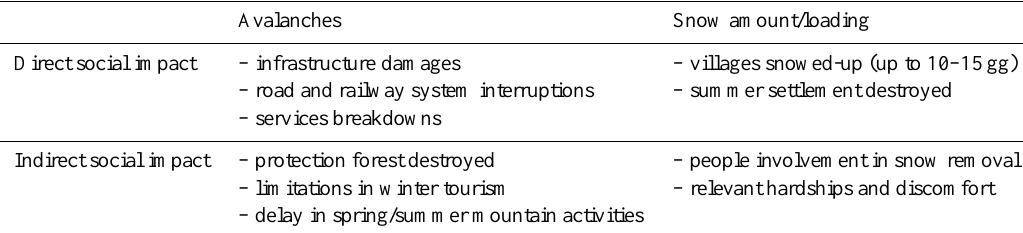
Table 1. The heavy snowfall impacts and social relevance.